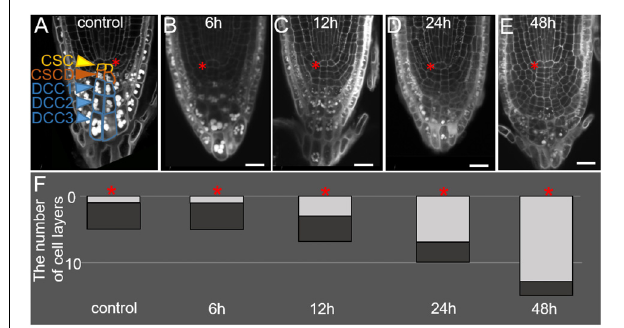
FIGURE 1 | Changes in the root tip structure during DEX incubation in the 35S:WOX5-GR line. (A–E) The root tip anatomy of 35S:WOX5-GR root tips after 0 h (A) , 6 h (B) , 12 h (C) , 24 h (D) , and 48 h (E) of DEX treatment. N = 10. CSC, columella stem cells; CSCD, columella stem cell daughters; DCC, differentiated columella cells. (F) The changes in the number of layers for stem-like cells (light gray) and DCC cells (dark gray) in columella is represented. The QC location is marked by the red asterisks. The bar scale – 20 µ m.